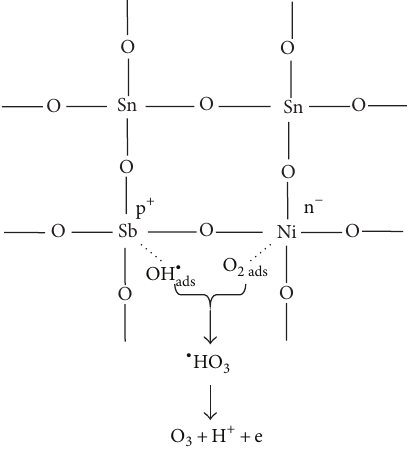
Figure 2: Mechanism for ozone formation on